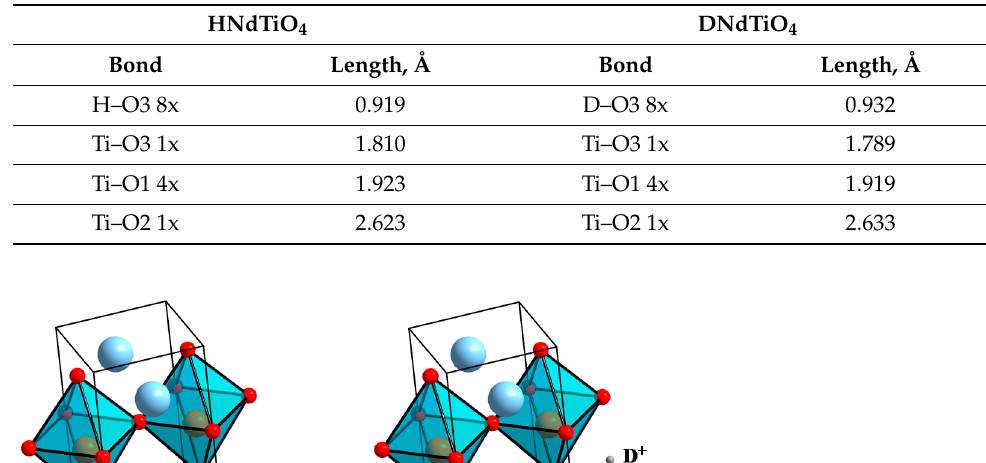
Table 3. Comparison of some bond lengths in HNdTiO 4 and DNdTiO 4 [64].